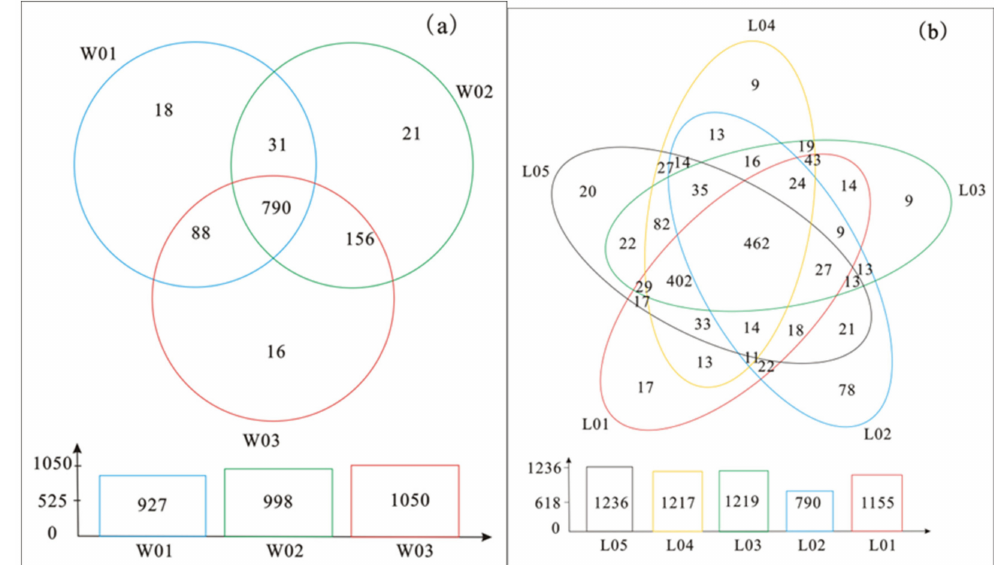
Figure 6. The Venn diagrams of samples (( a ) shows the number of operational taxonomic units (OTUs) of soil bacteria at di ff erent depths, and ( b ) shows the number of OTUs at 15 cm under di ff erent vegetation